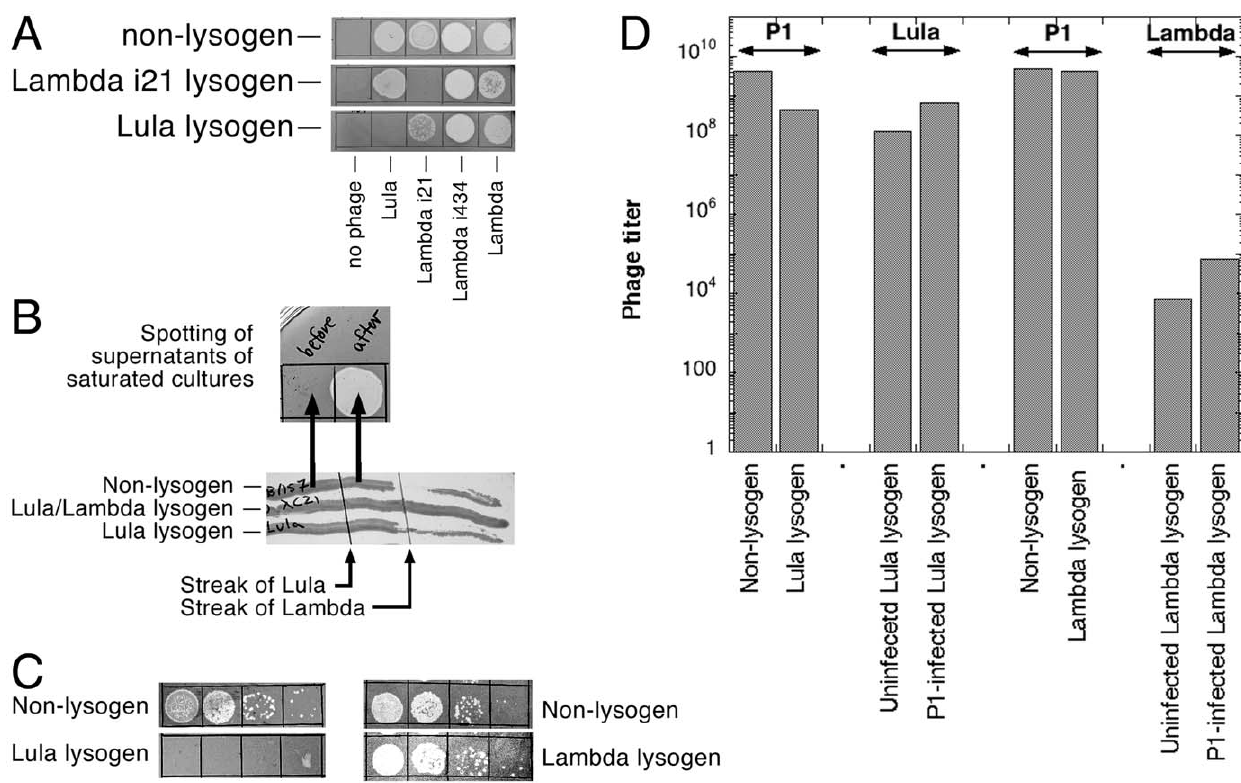
Figure 2. Interaction with Lambda, T4 and P1 phages. A. Plating of Lula and various Lambdas on each other’s lysogens. Strains are: non- lysogen, AB1157; Lambda i21 lysogen, MO ( l i 21 ); Lula lysogen, EL103. B. The lysogeny test. First, fresh colonies of a non-lysogen (AB1157), a Lula single lysogen (EL103) and a Lula/lambda double lysogen (MO ( l i 21 )(phi80)( l vir R )) are streaked horizontally from left to right across two vertical phage lines — the left one made with a high-titer stock of Lula, the right one made with a high-titer stock of Lambda. The next day, since the non- lysogen grew equally well both before and after crossing the Lula streak, we took cells from indicated locations, streaked them to single colonies and passed these clones through ‘‘Lula contamination’’ test (Fig. 1D). The test confirmed that, although no lysis is apparent, cells become Lula lysogens after crossing the Lula line. C. Lula lysogens do not plate T4. Serial dilutions of T4 stock were spotted by 10 m l on lawns of either a non-lysogen (AB1157), Lula lysogen (EL103) or Lambda lysogen (EL104). D. Interaction of Lula and Lambda lysogens with P1. The P1 columns: P1 lysate